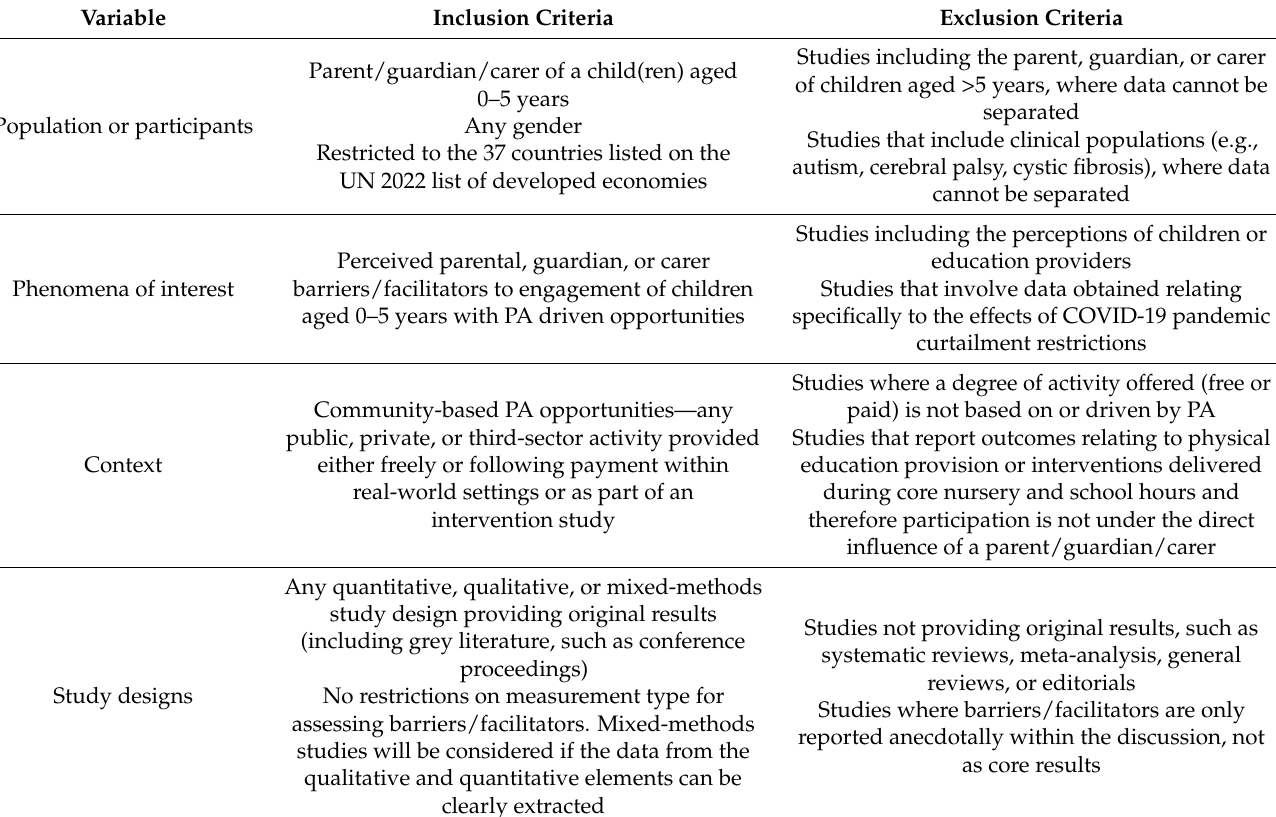
Table 1. Study inclusion and exclusion